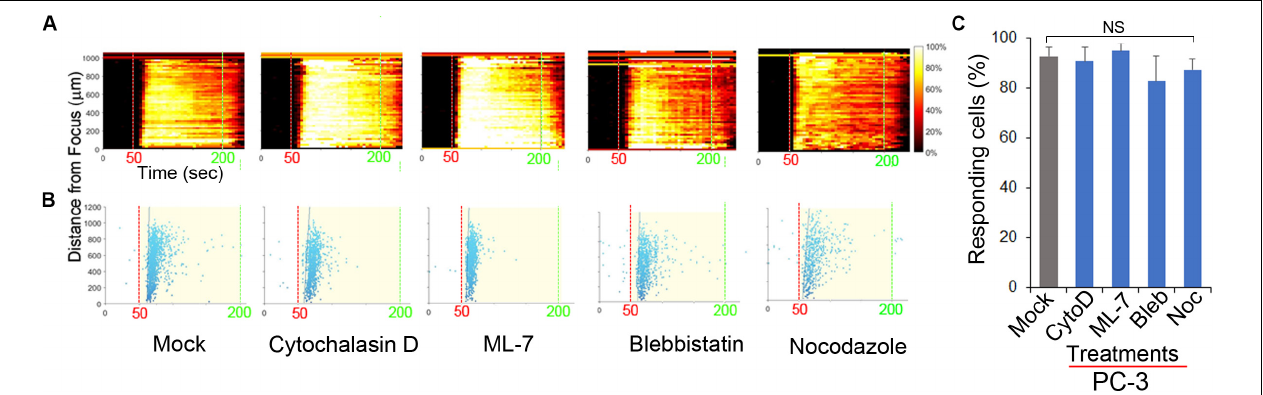
FIGURE 6 | Effect of inhibitors of cytoskeletal support and actomyosin on FUS-induced Ca 2 + responses in PC-3 cells. The responses are represented when cells were treated with mock, 2 µ M CytochalasinD (CytoD), 5 µ M ML-7, 5 µ M Blebbistatin (Bleb), and 1 µ M Nocodazole (Noc). (A) The percentage of responding cells over time. (B) The time at which each cell first responded to the stimulus. (C) Percentage of responding cells after the treatments. Cytoskeletal support and actomyosin did not affect FUS-induced calcium responses. None of them reduced the calcium responses, suggesting a distinctiveness of FUS. n = 4. Error bars, s.e.m., NS, not significant, by a one-tailed t